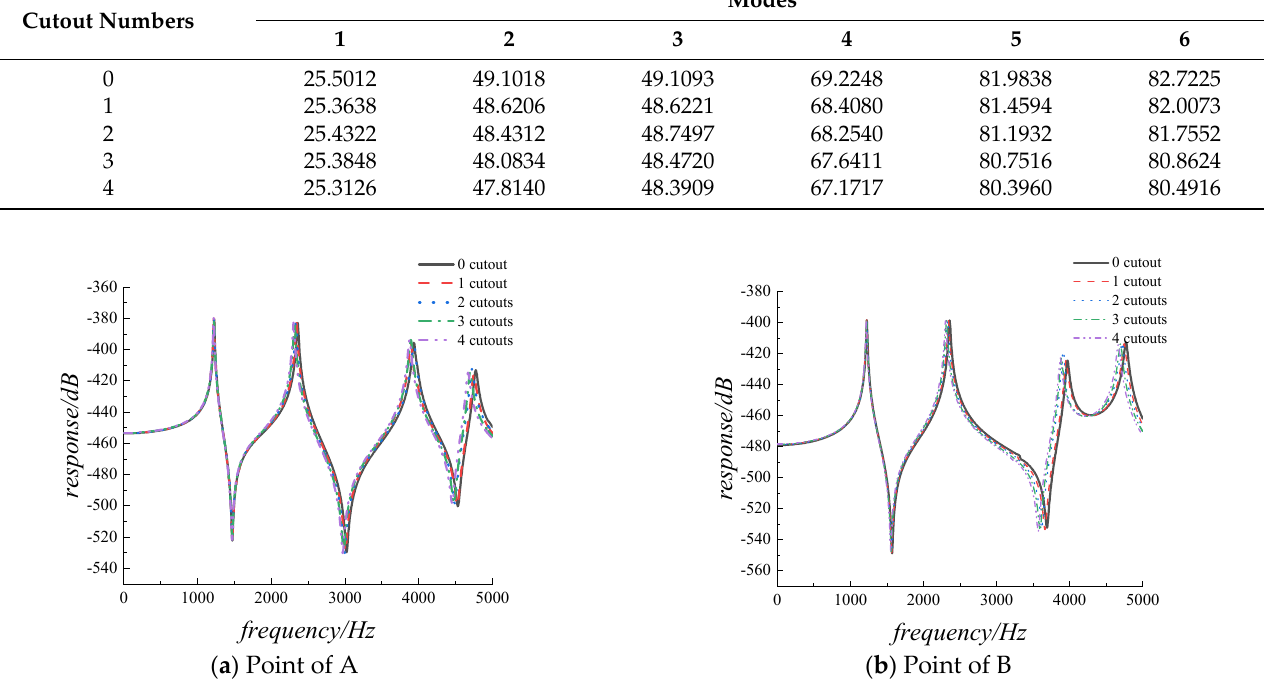
Figure 11. The displacement response for FGMs square plate with different cutout numbers. Table 10. The first six non-dimensional frequency parameters of the FGMs square plate with diverse cutout numbers.